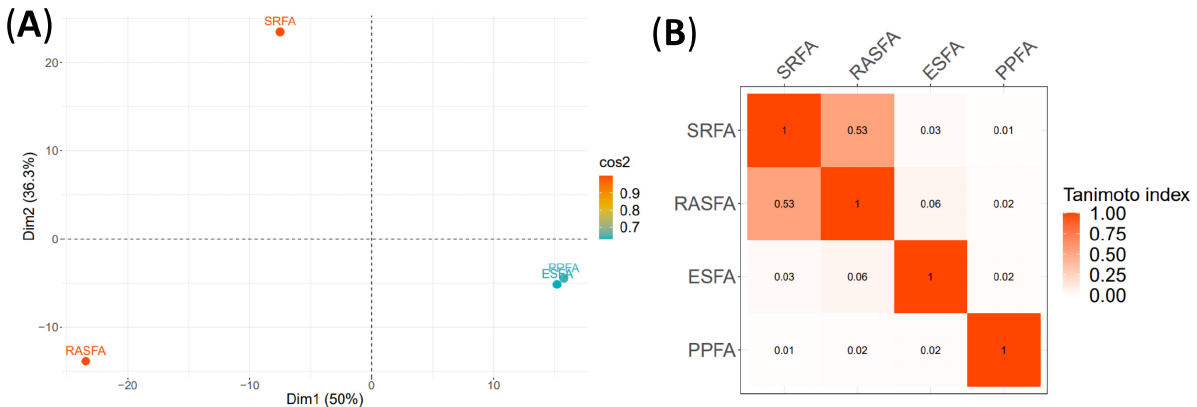
Figure 8. Principal component analysis (PCA) showing score plots ( A ) and Tanimoto similarity scores based on the normalized abundances of peaks extracted from ESI-QTOF mass spectra under negative mode ( B ) for the Suwannee River, Elliott soil, Pahokee Peat and recirculating aquaculture systems fulvic acids (SRFA, ESFA, PPFA and RASFA).